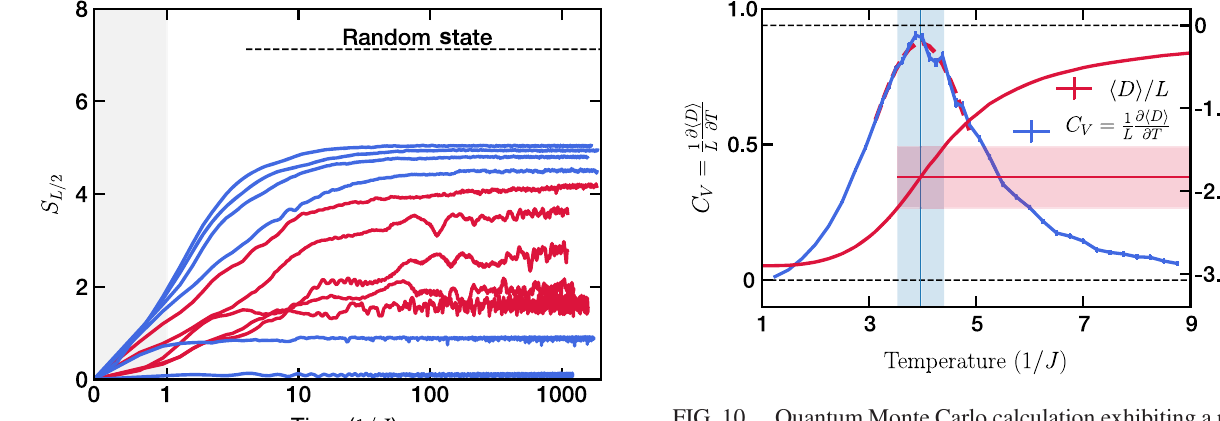
FIG. 10. Quantum Monte Carlo calculation exhibiting a peak in the heat capacity. We identify the position of the peak as the position of the finite-size transition or crossover between para- magnetic and ferromagnetic phases. This occurs at T L ¼ 22 c =J ¼ 3 . 97 (cid:5) 0 . 44 . Using the measured value of the energy density h D i =L as a function of temperature, we can directly obtain the critical energy density ϵ L ¼ 22 C